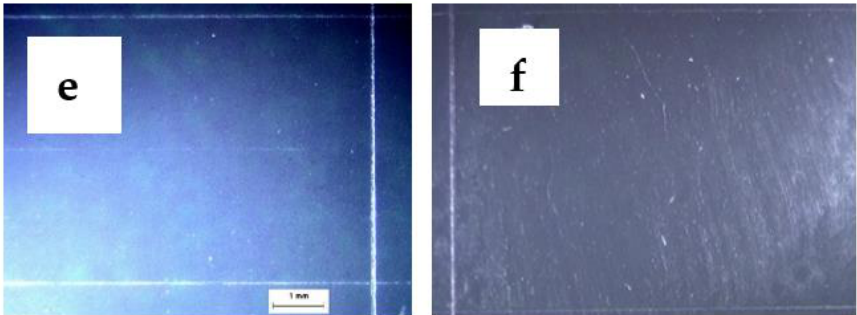
Figure 4. Surface detail reproduction for commercial and Exp VPS (medium-bodied) impression materials under wet conditions, where (c) Elt M, (d) Exp-I, (e) Exp-II and (f) Exp-III. The scale bar is 1 mm. Table 3. Surface detail reproduction for commercial and Exp VPS (medium bodied) impression ma- terials under dry, moist and wet conditions.